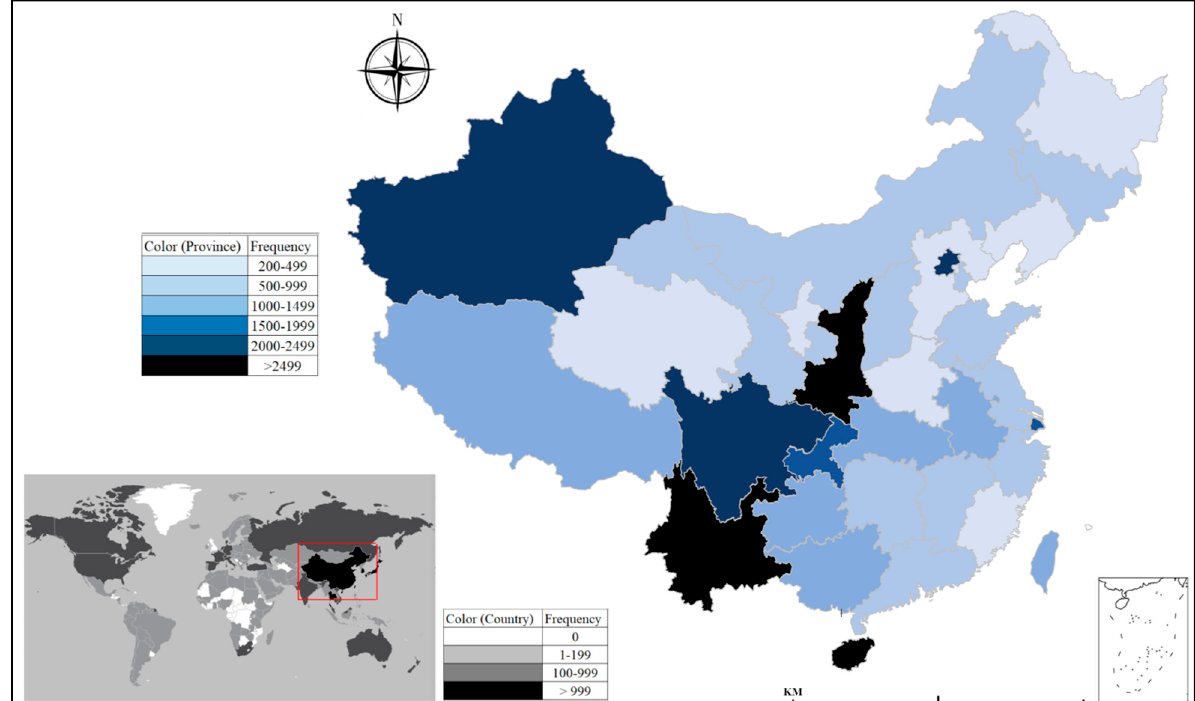
Figure 2. Number of Weibo posts and connected sources by year in study dataset.